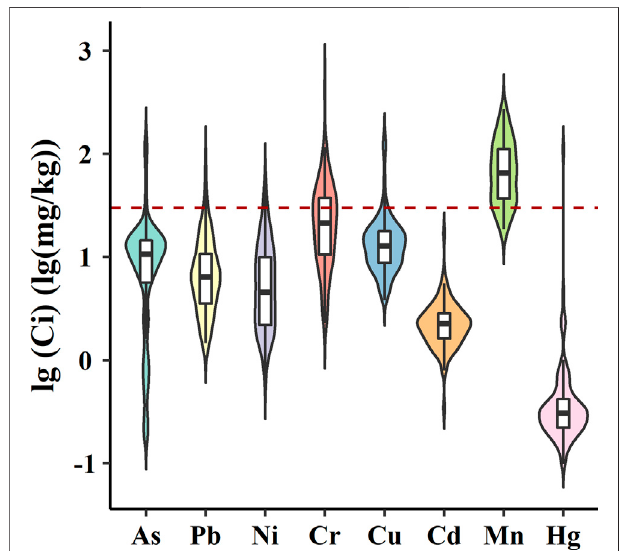
FIGURE 1 | Concentration of eight heavy metals in Pheretima . The dashed line represents the limits set in the Chinese Pharmacopoeia 2020